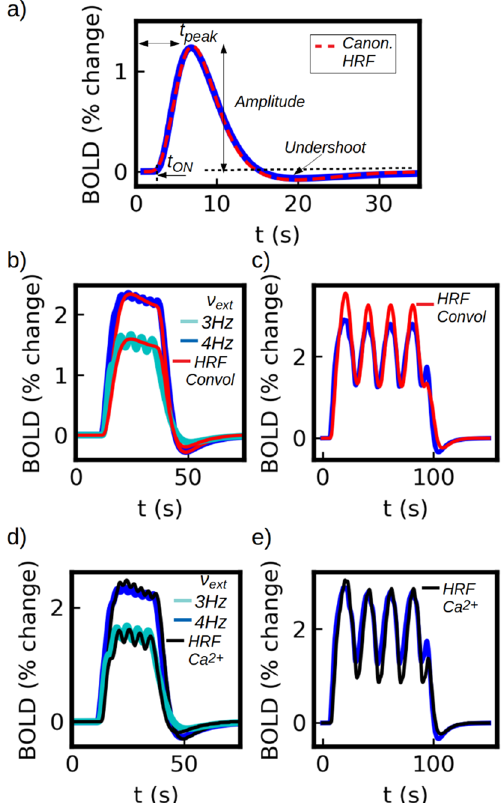
Figure 5. ( a ) Hemodynamic Response Function (HRF) obtained from our model, corresponding to a stimulus of 2 seconds and ν ext =4 Hz (blue solid line) . A fit with a double-gamma canonical HRF is shown (red dashed ) a 1 e − ( t − d 1 )/ b 1 − c ( t ) a 2 e − ( t − d 2 )/ b 2 . The coefficients from the fit are d 1 = 6 s, a 1 = 6 , b 1 = 1 s line), HRF C = ( t d d 2 1 , c = 0.07 , d 2 = 18 s, a 2 = 12 , b 2 = 1.5 s, in good agreement with experimental values 52,53 . In panel ( b and c ) we show the BOLD response together with the result from the convolution of Eq. (13). In panel ( b ) we show the results for a 24 seconds stimulus with ν ext =3 and 4 Hz. In panel ( c ) we show the results for a sinusoidal stimulus centered at ν ext =4.2 Hz and amplitude of 1.6 Hz. We see that the results from the convolution fails to reproduce the simulations for the higher values of the input as the system moves away from the linear regime. In panel ( d and e ) we show the BOLD response estimated via the convolution of the HRF with the calcium activity (for the same stimuli as panels ( b , c ) respectively). From panel ( e ) we see that the results from the convolution can reproduce the simulations except for the lower values of the input (close the threshold for calcium activation) as the system moves away from the linear